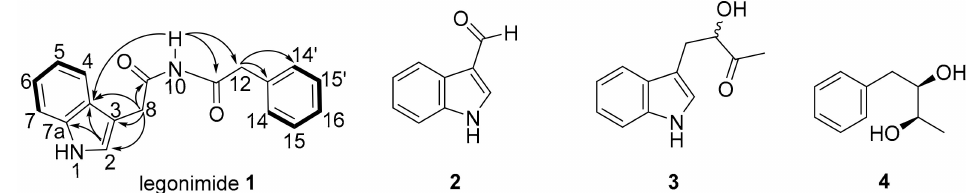
Figure 1. Compounds 1–4 isolated from Streptomyces sp. CT37 ISP2 extract; compound 1 with correlation spectroscopy (COSY) ( — ) and key heteronuclear multiple bond correlation (HMBC) ( → ) correlations. Compound 1 was isolated as a pale yellow amorphous solid. The HR-ESIMS spectrum of 1 + exhibited a prominent peak at m / z 293.1280 [M + H] corresponding to the molecular formula of + C 18 H 16 N 2 O 2 ( calcd for C 18 H 17 N 2 O 2 293.1285, ∆ = − 1.70 ppm) possessing 12 degrees of